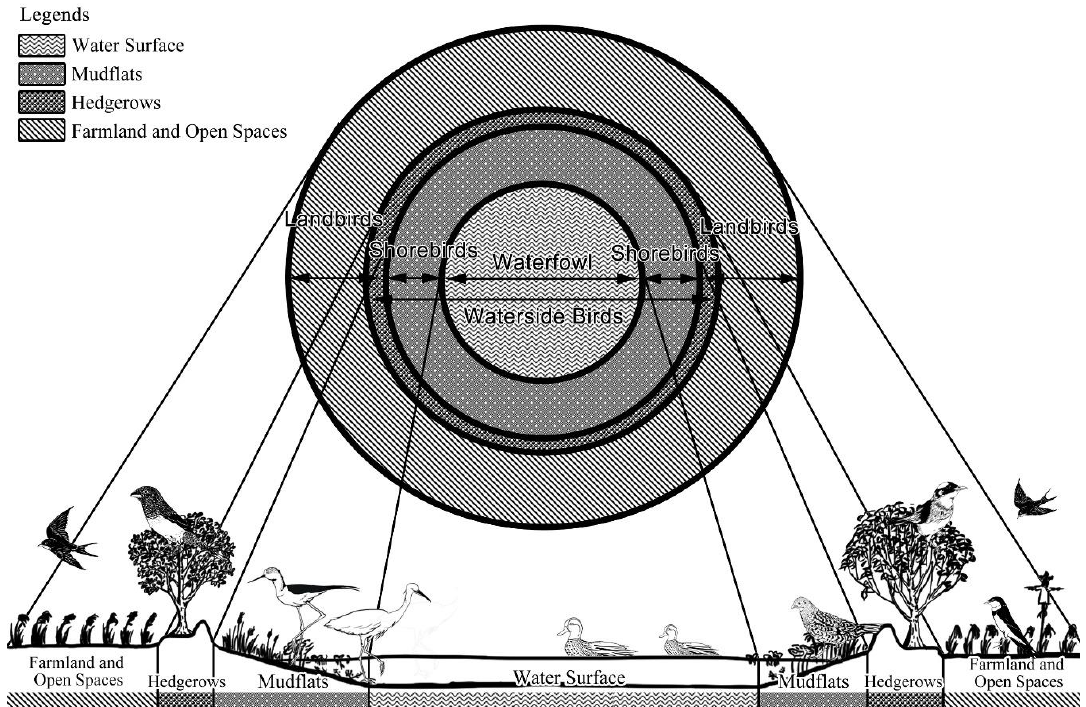
Figure 3. Distribution patterns of relatively dominant bird species in pond habitats successively from the pond’s core to adjacent areas.